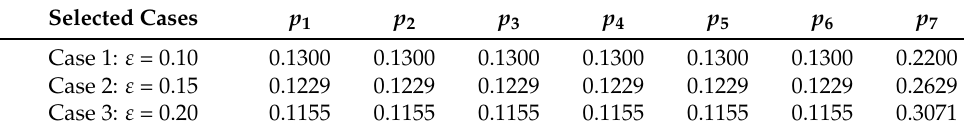
Table 3. Probability distributions included in the simulation study for k = 7.